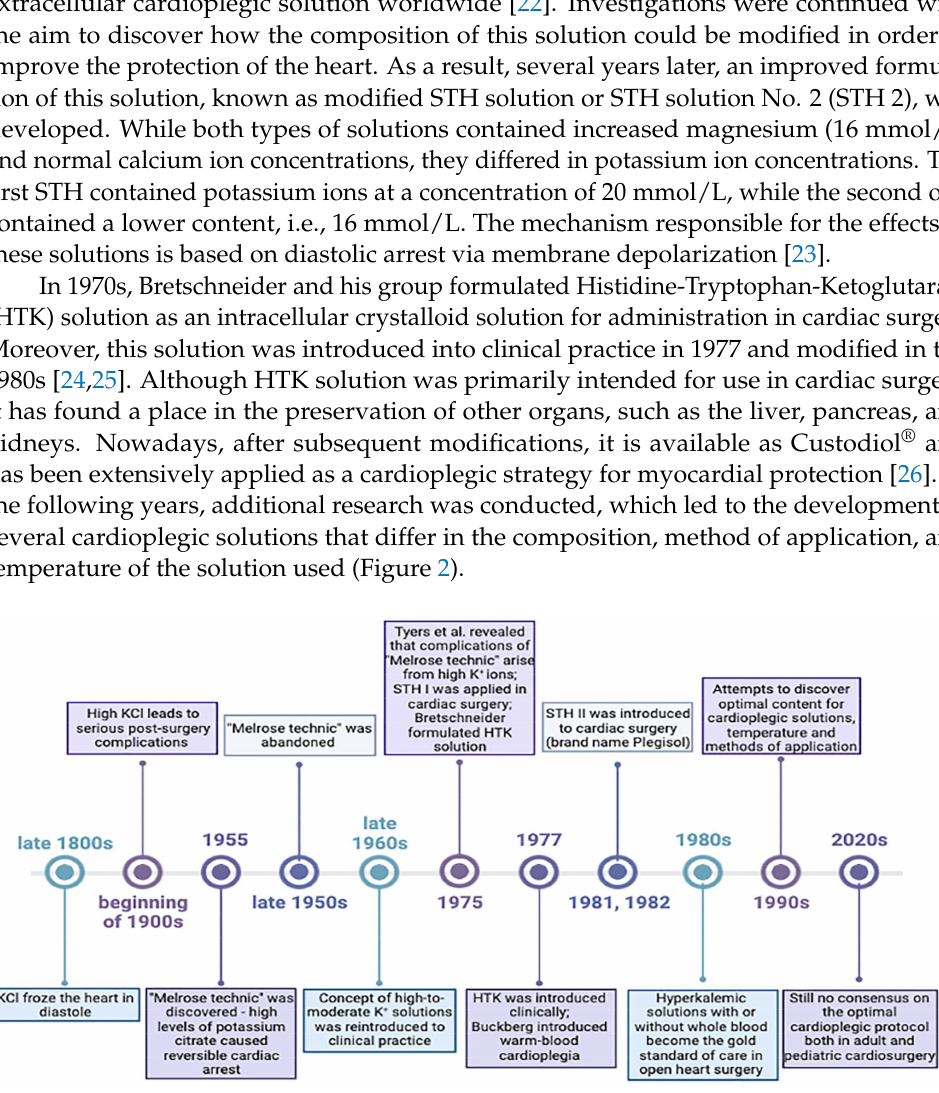
Figure 2. Cardioplegia as a tool for heart preservation throughout